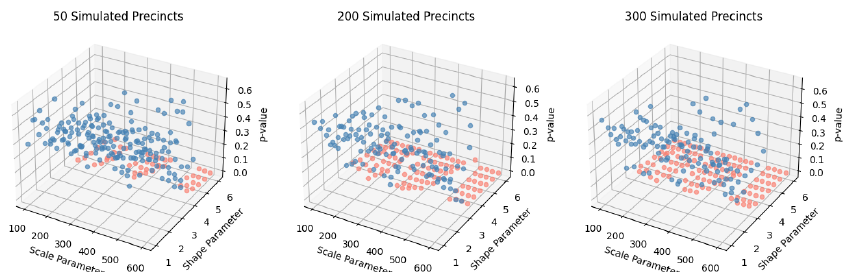
Figure 5. First Digit Base 10 Monte Carlo Analysis of Simulated Discrete Weibull Distributions with Various Choices of Parameterizations and Precinct Sizes Using Chi Squared Testing. p -values above 0.05 (plotted in blue) indicate conformance to 1-BL 10.